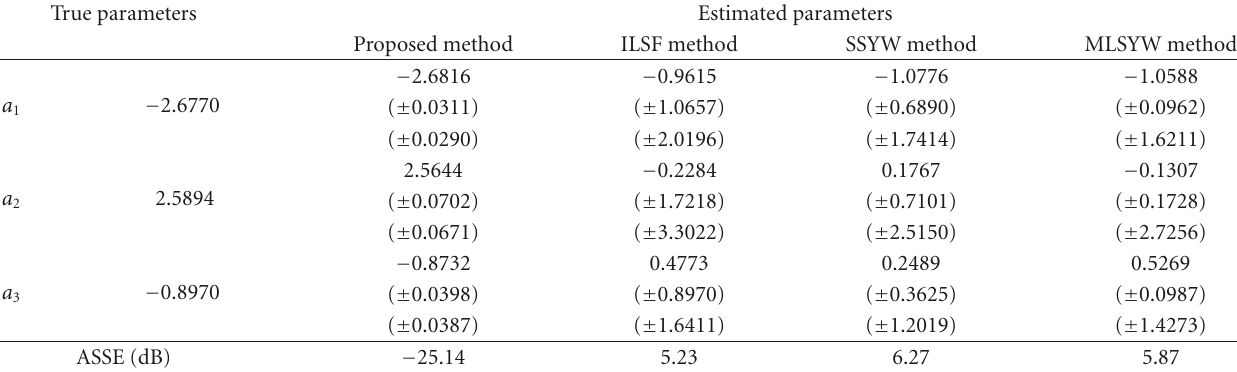
True parameters Estimated